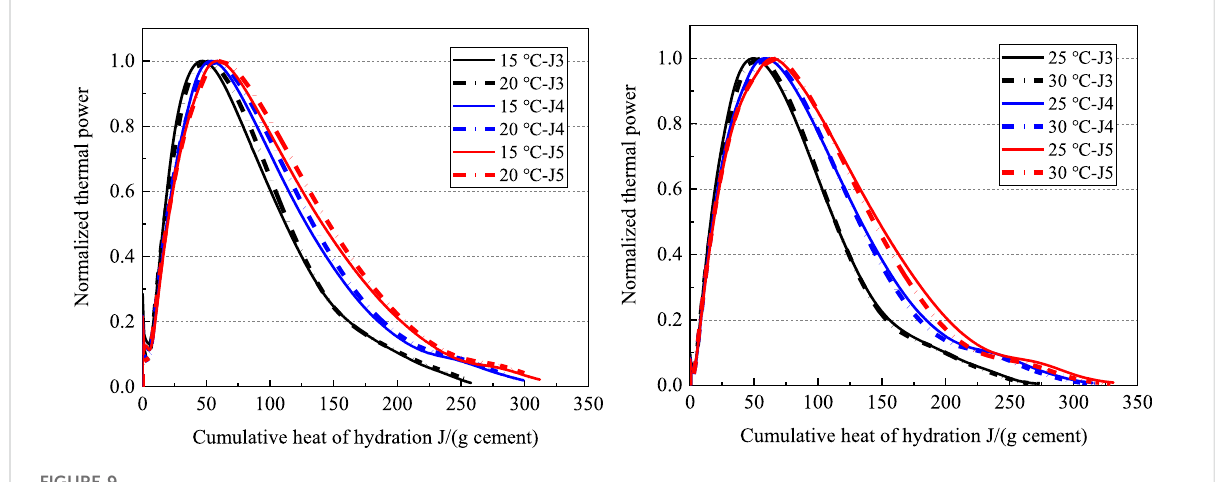
FIGURE 9 Thermal power vs. cumulative heat of hydration after normalization (Jiahua Class G cement).